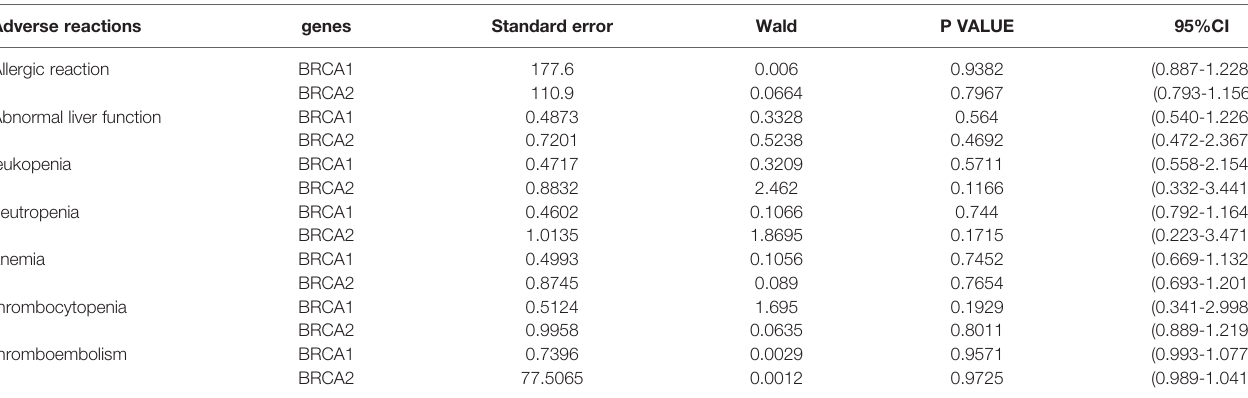
TABLE 2 | Correlation between pathogenic BRCA variants and adverse reactions. Adverse reactions Allergic